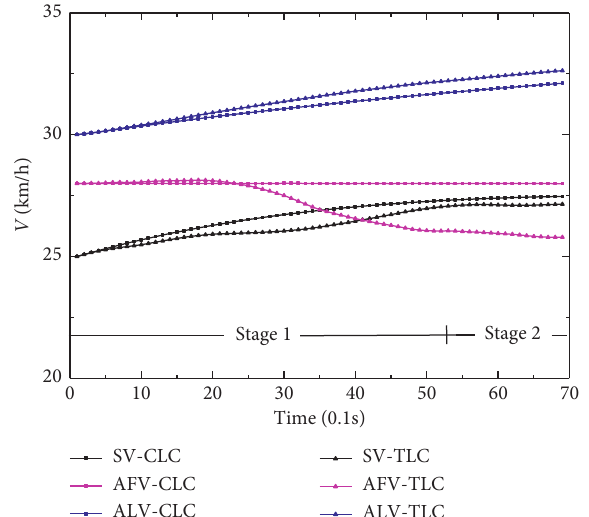
Figure 12: Vehicle speeds during lane changing.